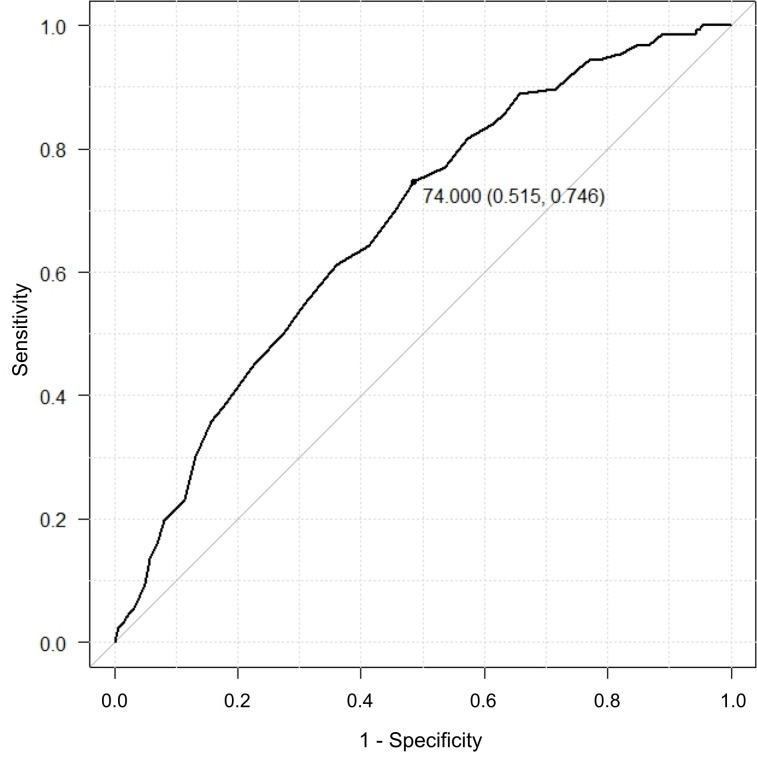
Receiver operating characteristic curve (ROC) for age.The cut-off value is 74.0, specificity is 0.515, and sensitivity is 0.746.